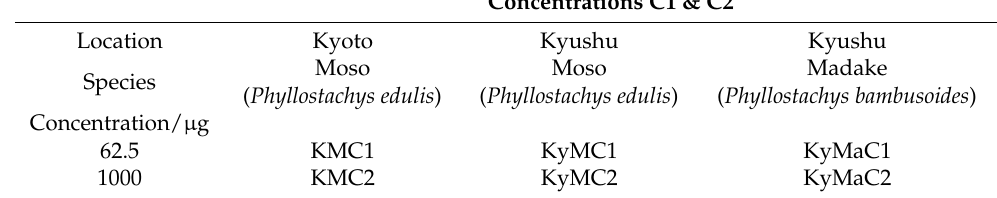
Table 1. Abbreviations of various types of antibacterial agents of bamboo based on their location, species and concentration.